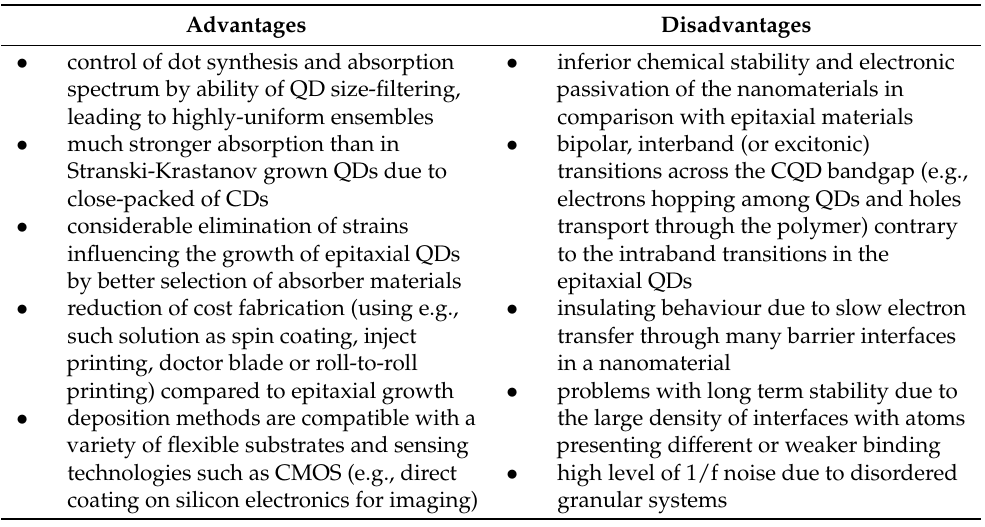
Figure 18. The wavelengths range that can be detected by materials commonly used in imaging ap- plications. Table 2. CQD photodetectors advantages and disadvantages in comparison with single crystal QD